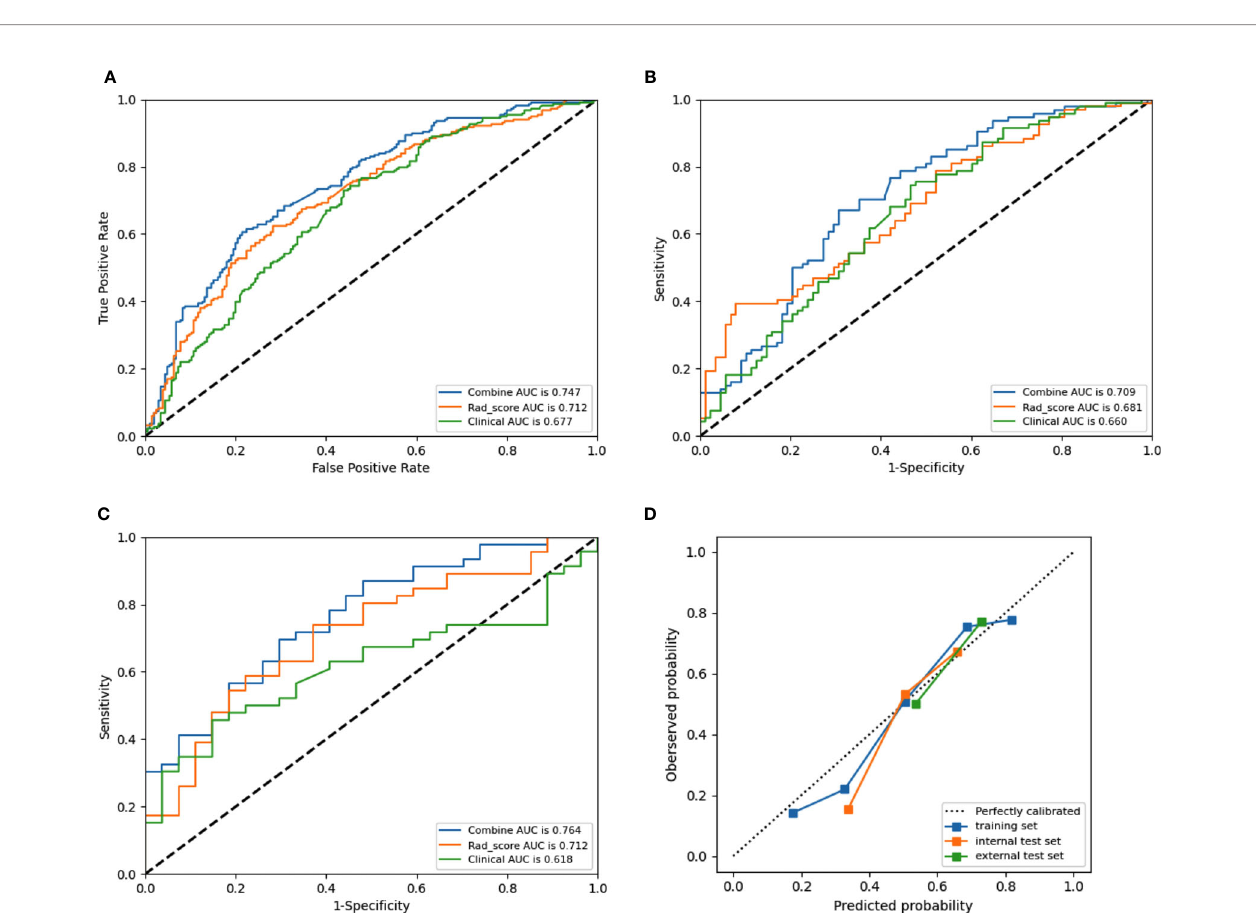
FIGURE 6 | Receiver operating characteristic (ROC) curves of the combined model (blue lines), Rad-score model (orange lines) and clinical model (green lines) in the training set (A) , internal test set (B) set, and external test set (C) , respectively. Calibration curves (D) of the combined model in the training and test sets, respectively. The diagonal dotted line represents an ideal prediction, while the red line represents the performance of the training set, the blue line and black line represents the performance of the internal test set and external test set, respectively, Closer fi t to the diagonal dotted line indicates a better prediction.